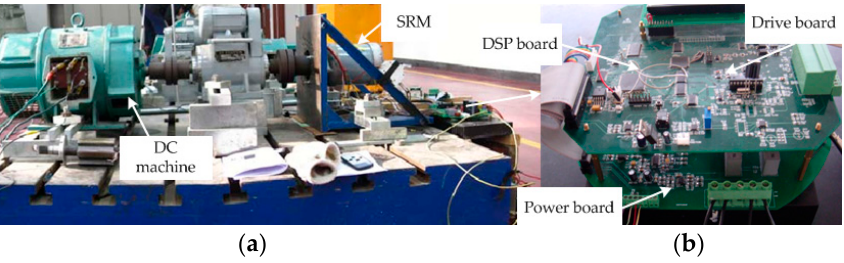
Figure 8. Experimental platform: ( a ) overall test bench; and ( b ) drive control and fault diagnosis sections.